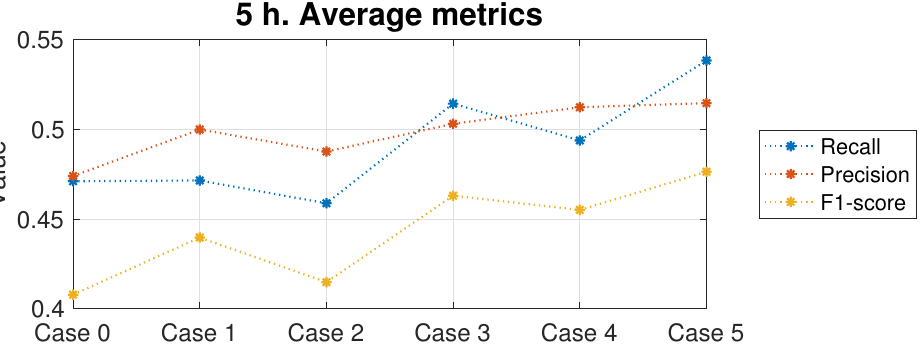
Figure 19. Average metrics of all the classification methods considering the 6 different scenarios assessed, for a time prediction horizon of +5